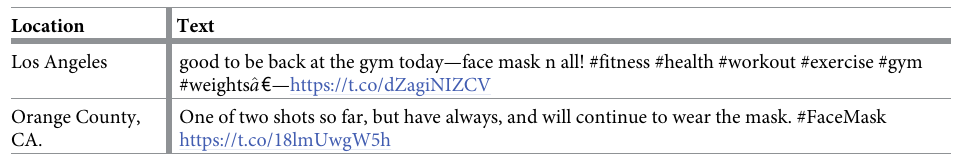
Table 1. Text from sample